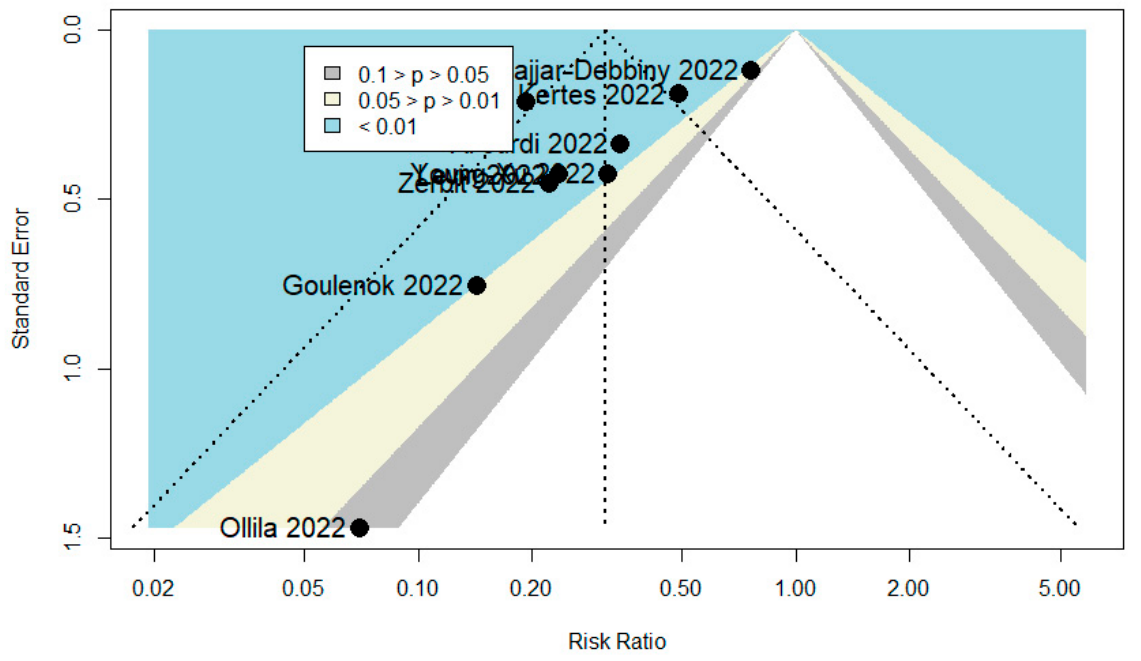
Figure 5. Funnel plot to evaluate publication bias for the pooled effect size to determine the rate of RT-PCR positivity for SARS-CoV-2 associated with TGM/CGM-based treatment in patients at high risk for breakthrough and severe SARS-CoV-2 infection.